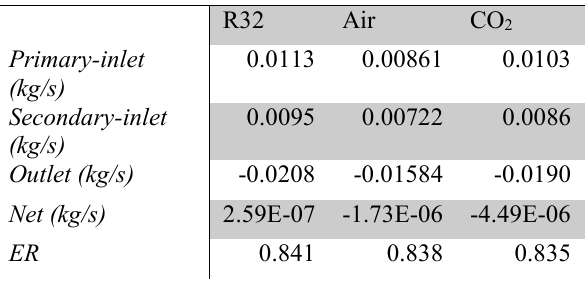
Table 3. Mass fluxes of ideal